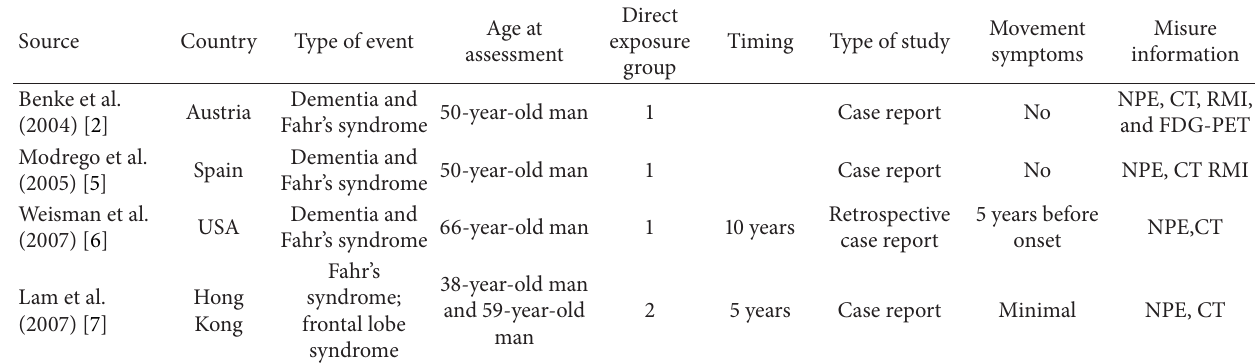
Table 1: Summary of FD case with pure dementia.